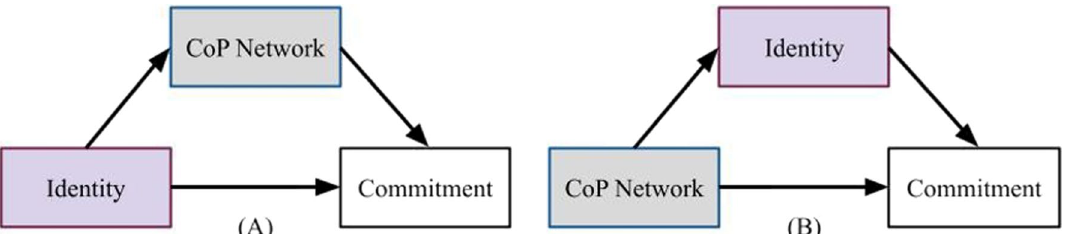
Fig. 2 Hypothesized relationships between teacher identity, CoP networks, and commitment to the profession. Model A predicts that identity influences commitment to remaining in the profession but this relationship is mediated by the characteristics of the CoP network. Model B predicts that the characteristics of teachers’ CoP networks influence their dispositions on remaining in the profession but this relationship is mediated by their